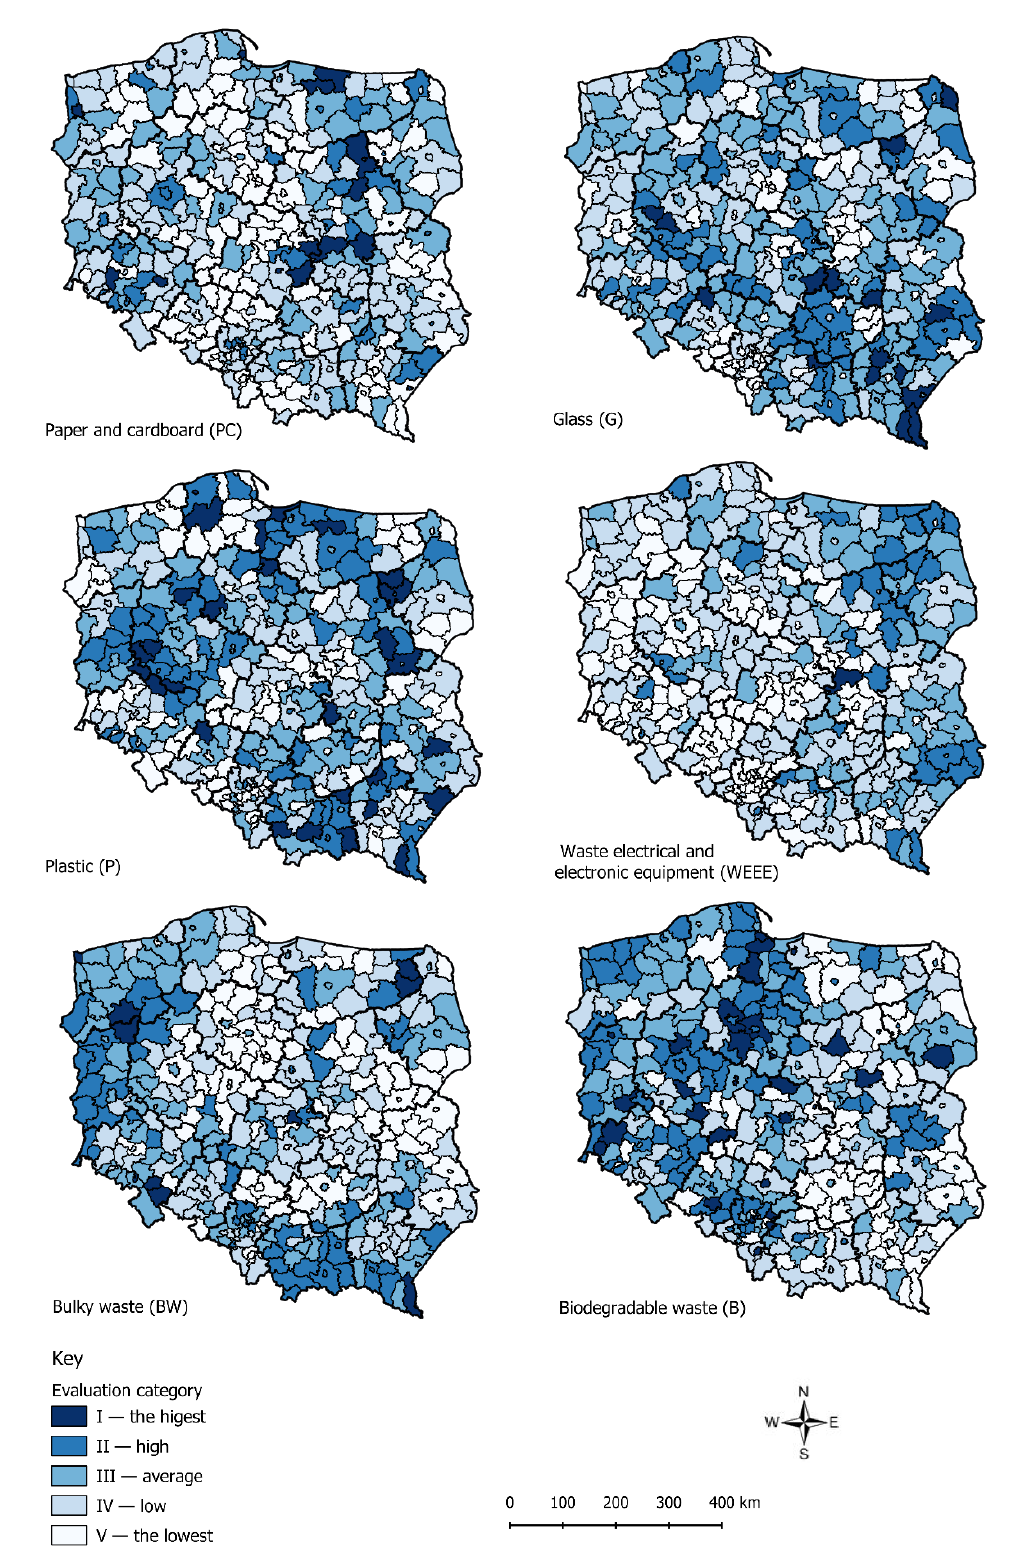
Figure 6. The range of the categories of correct waste management for given fractions of selectively collected waste in counties in Poland. Source: own elaboration.